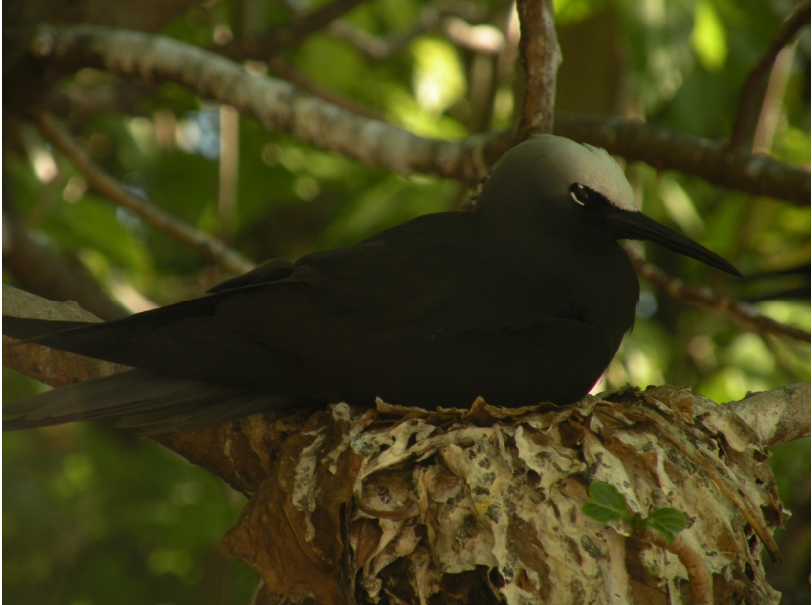
Figure S4. White-capped noddy ( Anous minutus ) nesting in Pisonia ( Pisonia grandis ) tree. The lack of nesting material and great number of noddies present (est. 70,000 birds; [32]) restricts bird nest make-up to only Pisonia